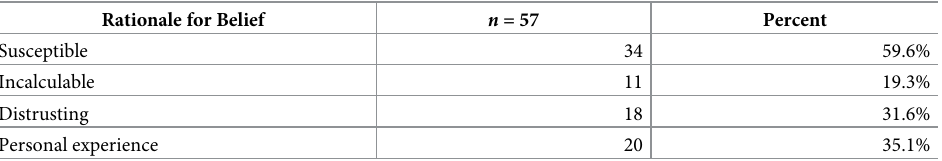
Table 6. “Vulnerable to harm”